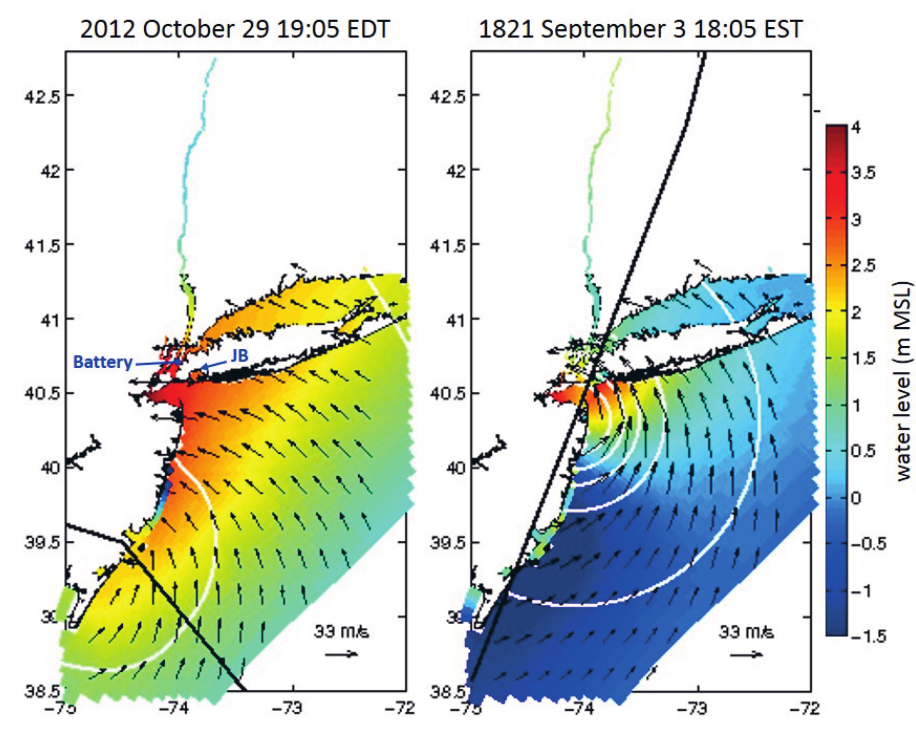
Figure 3. Hurricane Sandy ( left ) and the 1821 Hurricane ( right ) storm track ( black lines ), isobars ( white lines ), wind vectors, and simulated water levels relative to mean sea level near the time of final landfall. The 1821 simulation is performed on the mean sea level for the 1983–2001 epoch. Blue arrows in the left panel point to locations of the Battery tide gauge and Jamaica Bay